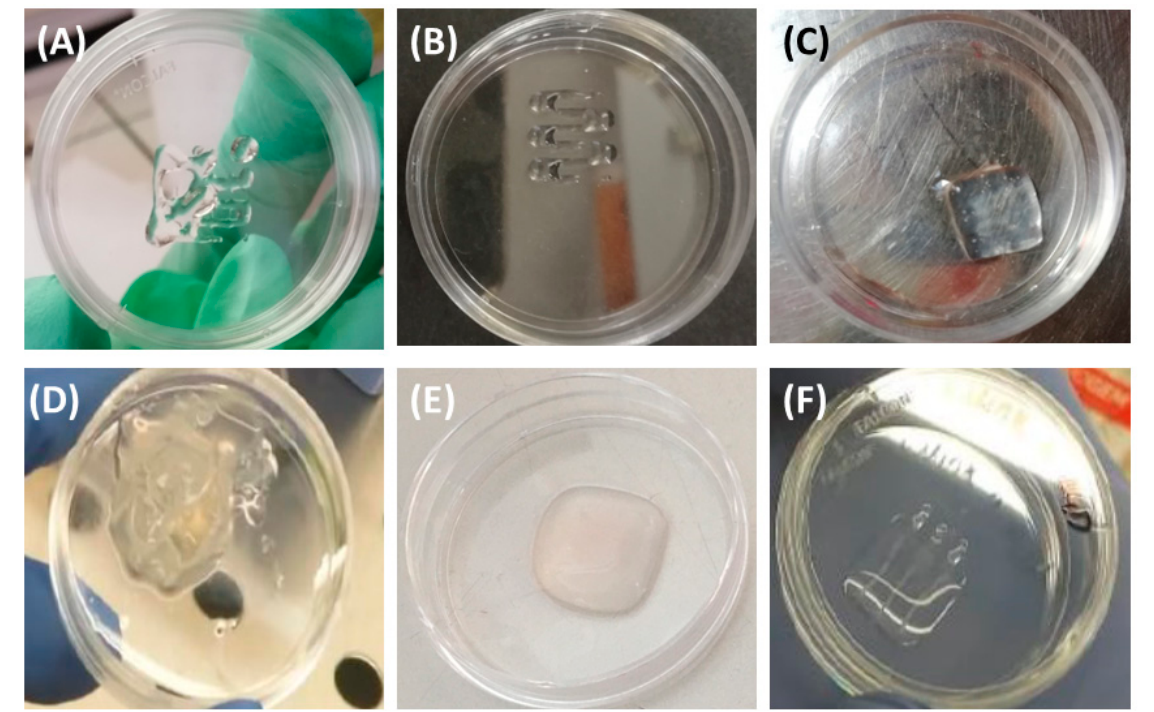
Figure 1. Alginate bioink optimization. ( A ) Printed grid of alginate bioink with a ratio between alginate solution of 3.5% w / v and 0.67% w / v CaCl 2 equal to 25:9, Pr > 1. ( B ) Printed half-grid of alginate bioink with ratio 25:10, Pr < 1. ( C ) Cube of (1 × 1 × 0.15) cm 3 made of alginate bioink before the crosslinking process. ( D ) Cube of (1 × 1 × 0.15) cm 3 made of alginate bioink without D-mannitol and following the crosslinking process with 0.67% w / v CaCl 2 . ( E ) Cube of (1 × 1 × 0.15) cm 3 made of alginate bioink with D-mannitol after the crosslinking process with 0.67% w / v CaCl 2 . ( F ) 3D bioprinted sample of cervical tumor model: a cube of (1 × 1 × 0.15) cm 3 made of alginate bioink, inside of which are three printed lines of the bioink containing HeLa cells.